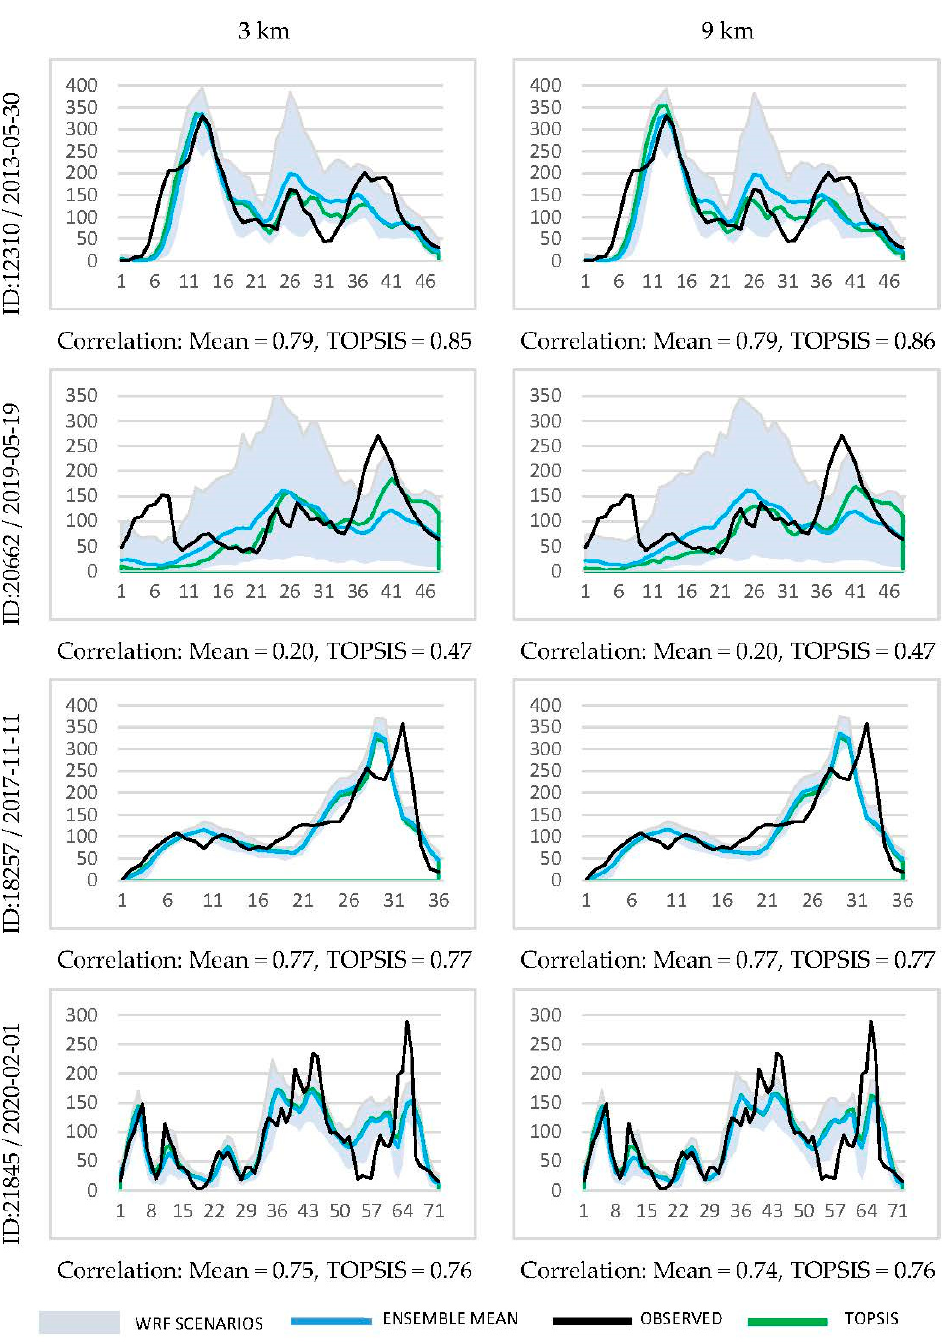
Figure 3. Same as Figure 2 but for the Baden–Wurttemberg area.